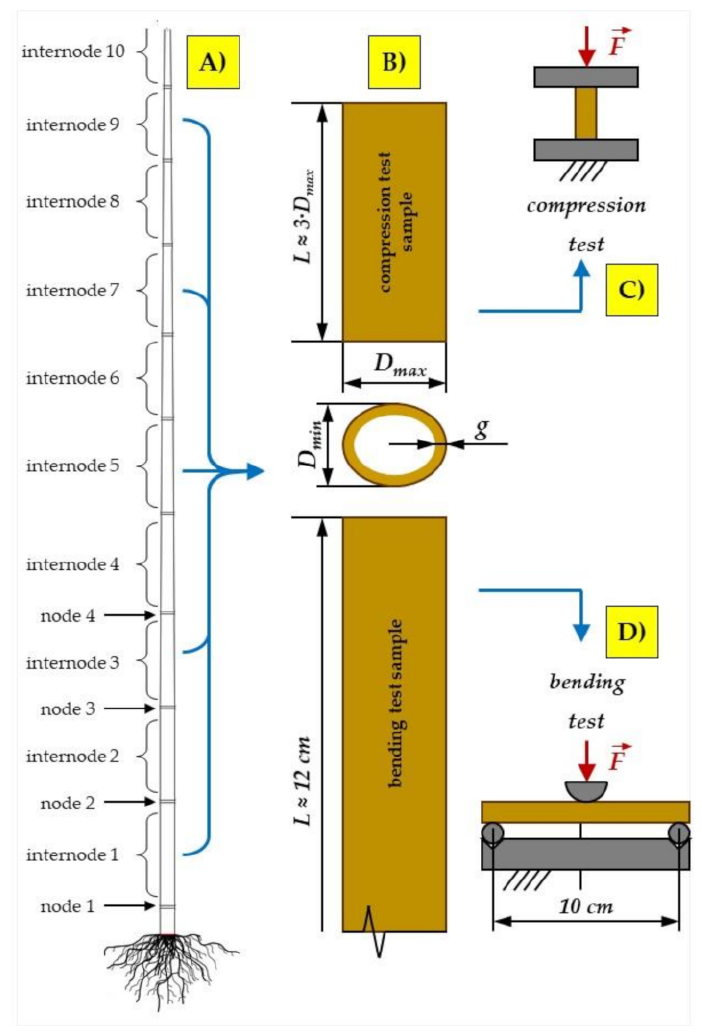
Figure 1. Diagram of preparation and dimensions of samples for compression and bending tests: ( A ) diagram of miscanthus stalk and internode from which samples were taken; ( B ) designation of characteristic dimensions of samples: D min —minimum stalk diameter, D max —maximum stalk diameter, g —stalk wall thickness; ( C ) diagram of the compression test along the fibers; ( D ) diagram of the three-point bending